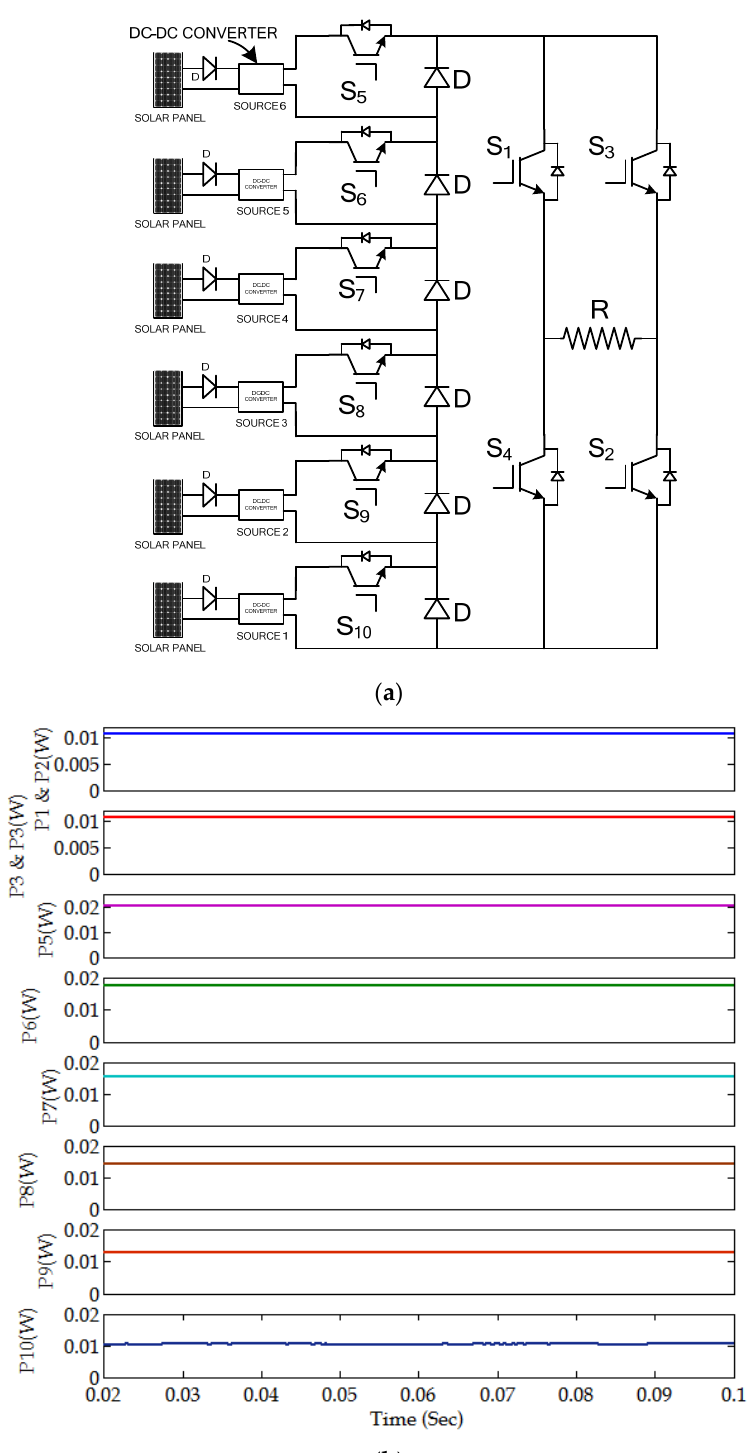
Figure 1. ( a ) 127-level reduced switch multilevel inverter. ( b ) Power losses in all the switches 127-level MLI.